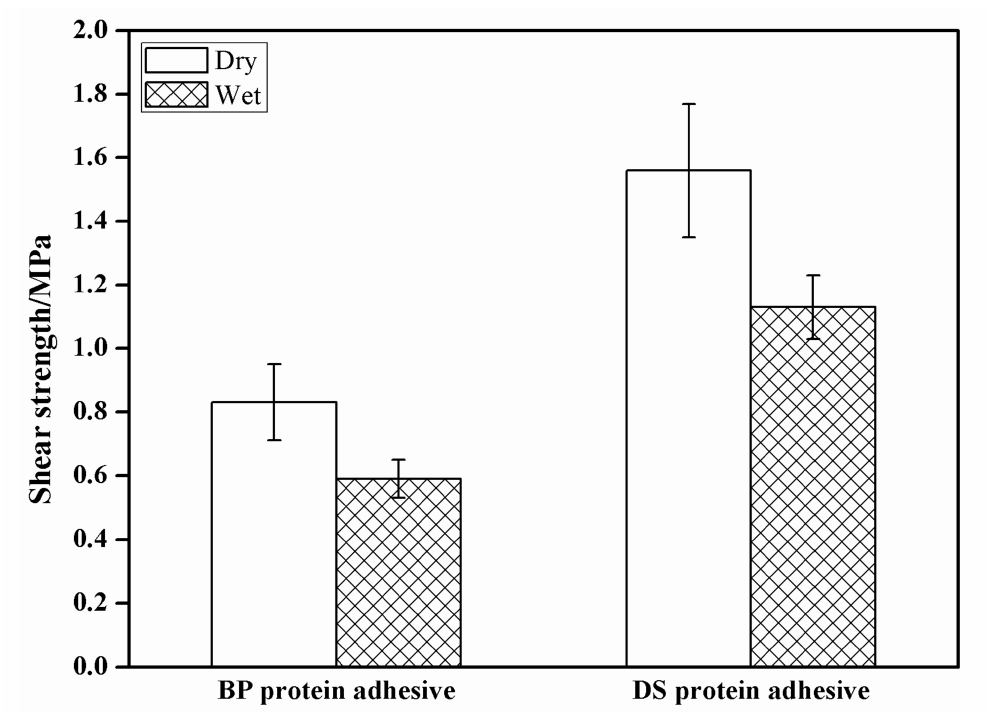
Figure 7. Bonding properties of BP protein adhesive and DS protein adhesive. Note: all dry wood failures were over 50% and those of BP protein adhesive were low. All wet wood failures were less than 30% and those of BP protein adhesive were